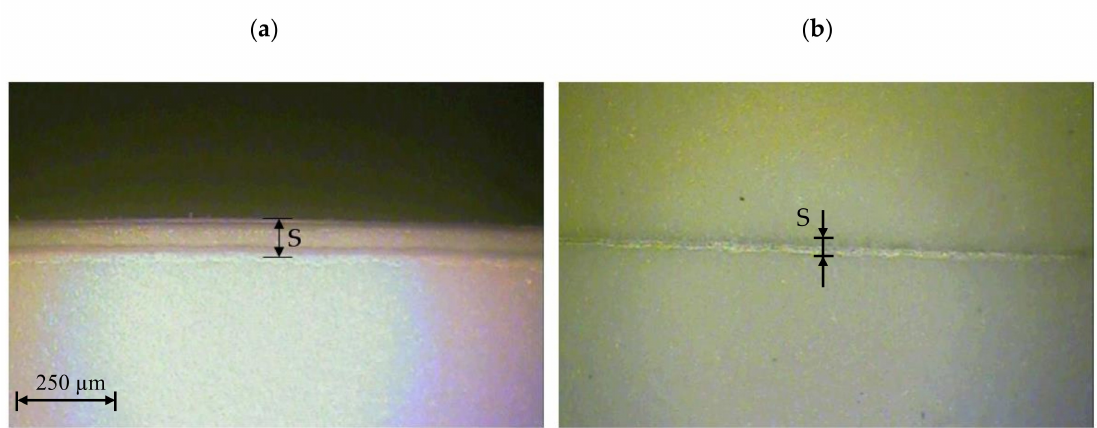
Figure 5. View of the cut surface of foil with thickness t = 50 µ m: ( a ) v = 0.222 m / s, f = 39 kHz, ( b ) v = 0.751 m / s, f = 20 kHz.